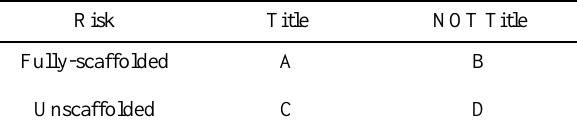
Relative Risk Ratio